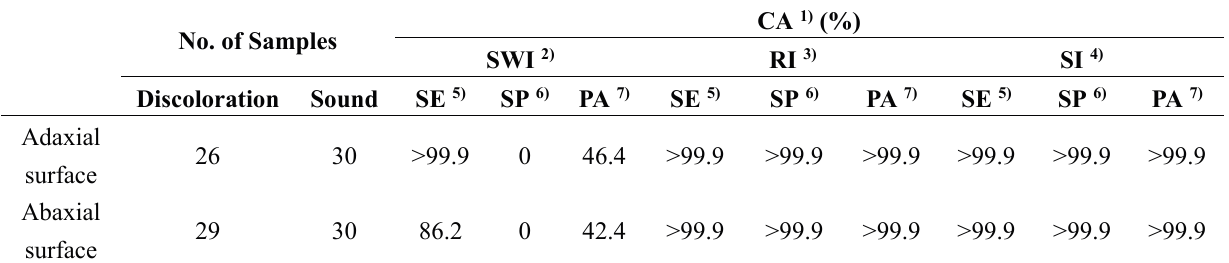
Table 3. The results of discoloration detection using images of lettuce surfaces for three imaging